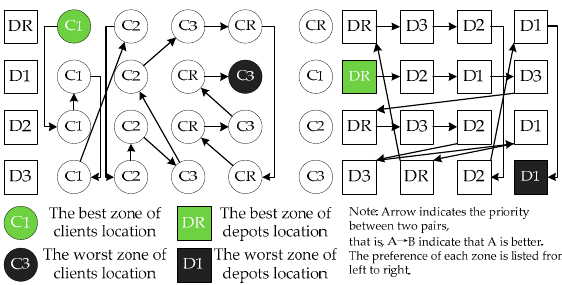
Figure 6. Preference of clients and depots locations.